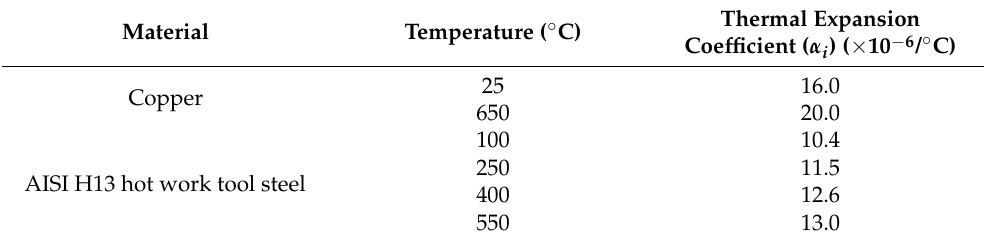
Table 4. The thermal expansion coefficients of copper and AISI H13 hot work tool steel. Material